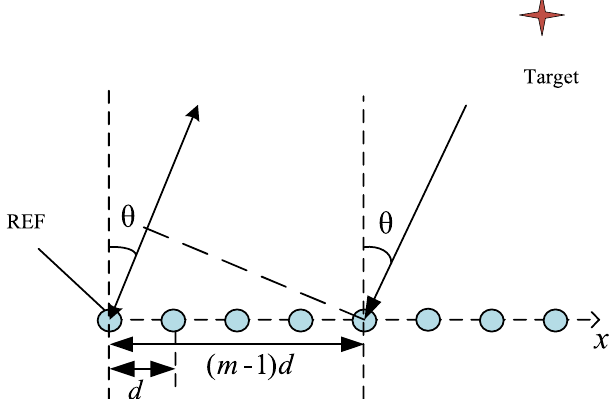
Figure 3. Target localization diagram of FMCW-MIMO